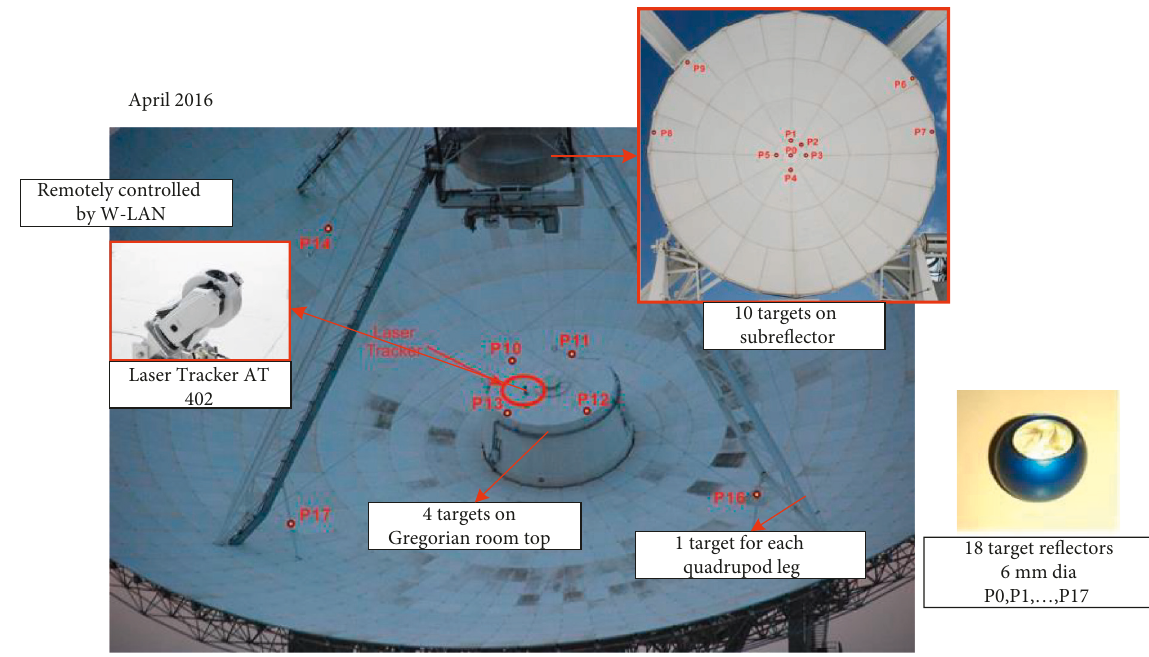
Figure 2: SRT measurement in